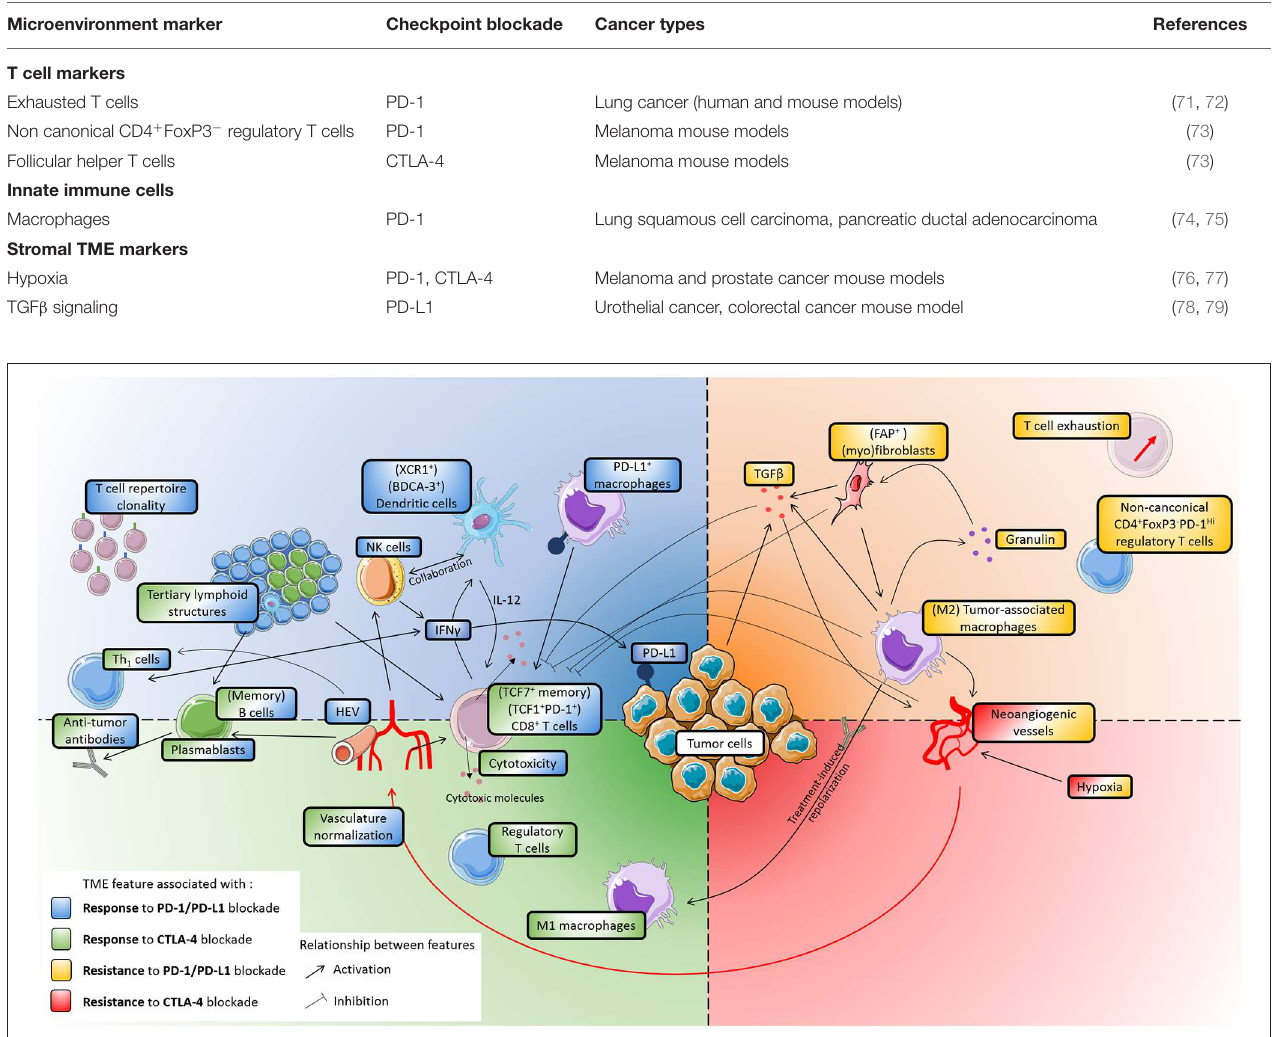
FIGURE 1 | Main features of the tumor microenvironment that influence patients’ response to immune checkpoint blockade. The figure is divided in four quarters, corresponding to association with either response or resistance, to either CTLA-4 or PD-1/PD-L1 blockade. Activating or inhibitory relationships between TME features are indicated by black arrows. Whenever phenotypes are indicated between brackets, it indicates that studies identified particular subsets as being associated with patients’ response. PD-L1 is the only target of ICB that is shown, as it is the only one which expression was directly shown to associate with patients’ response. Upper left (blue), features associated with increased response to PD-1/PD-L1 blockade: T cell repertoire clonality, NK cells, Dendritic cells, PD-L1 + macrophages, high endothelial venules, IFN γ . Lower left (green), features associated with increased response to CTLA-4 blockade: M1-polarized macrophages, regulatory T cells. (Left) (green and blue), some features are associated with an increased response to both CTLA-4 and PD-1/PD-L1 bloackade: CD8 + T cells, cytotoxicity, tertiary lymphoid structures, Th1 cells, B cells, plasmablasts, antibodies, vasculature normalization. Upper right (yellow), features associated with resistance to PD-1/PD-L1 blockade: M2-polarized macrophages, granulin, fibroblasts, TGF β , T cell exhaustion, non-canonical regulatory T cells. Lower right (red): no markers were identified as being associated solely with resistance to CTLA-4 blockade. (Right) (yellow and red), features associated with resistance to both CTLA-4 and PD-1/PD-L1 blockade: hypoxia, neoangiogenic vessels. Cell drawings originate from Servier Medical Art (https://smart.servier.com), distributed under a CC-BY 3.0 Attribution license